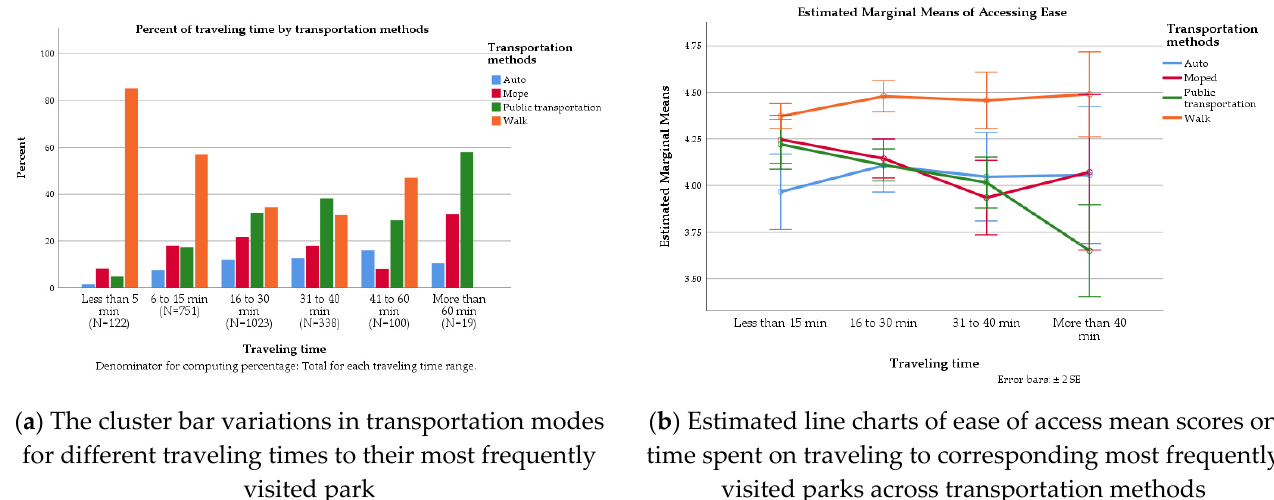
( b ) Estimated line charts of ease of access mean scores on time spent on traveling to corresponding most frequently visited parks across transportation methods Figure 4. Differences in traveling time and ease of access for respondents across selections on transportation modes for each most frequently visited park: ( a ) summary of transportation modes and traveling time; ( b ) relationships between ease of access, traveling time and transportation modes. The relationship between visit duration (for those visiting on foot) was explored against visiting frequency and the walking time required to visit the park. Firstly, visiting frequency significantly correlated with visit duration in the most frequently visited park on foot with a correlation value of X 2 (16) equal to 310.862 ( p < 0.001). Secondly, walking time was strongly related to visit duration with a correlation value of X 2 (12) equal to 343.519 ( p < 0.001). Specifically, Figure 5a,b show that there was a negative association between the frequency of visits and visiting time (with more frequent visits associated with shorter visiting times), and a positive association between the walking time and time spent visiting parks (with average longer visiting times associated with longer walking distances), respectively.